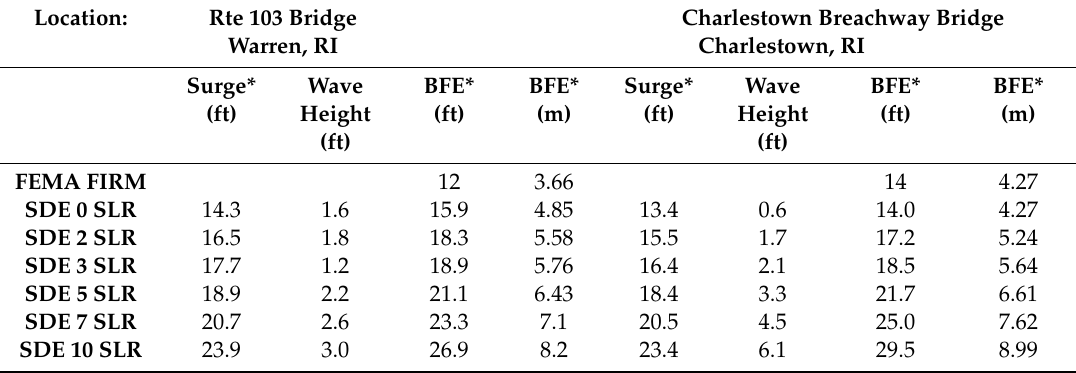
Table 2. Comparison of surge depth, wave height, and SDE values (ft, m) at two selected locations vs. 1% water level with sea level rise (SLR).